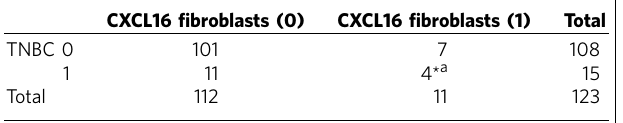
Table 2 | Crosstable a over TNBCs and CXCL16 fibroblast